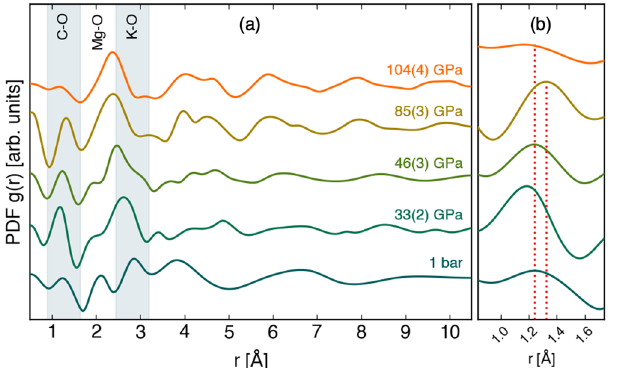
Fig. 3 Pair distribution functions of K 2 Mg(CO 3 ) 2 glass at different pressures. The PDFs were obtained by Fourier transforms of the structure factors (Supplementary Fig. 6a). a The gray shaded areas highlight the original position of C-O and K-O peaks (Mg-O in between) and emphasize their shift upon compression. b Close-up on the C-O peak (representing the bond length distribution).